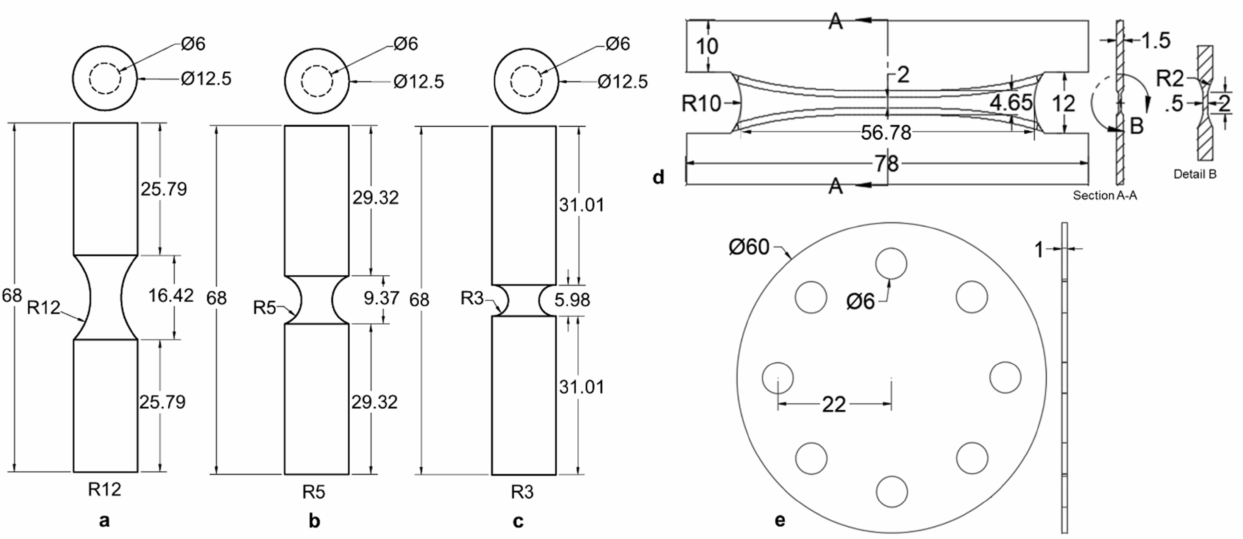
Figure 2. Drawings of mechanical test specimens used to calibrate fracture criterion. ( a – c ) The cylindrical notched tension geometries that were tested in the dense condition and with single, penny-shaped pores of varying diameter at the center. ( d ) The butterfly test geometry used to evaluate material properties under pure shear and ( e ) the punch test geometry used to evaluate equibiaxial tension. Both ( d , e ) were only tested in the dense condition. All dimensions in